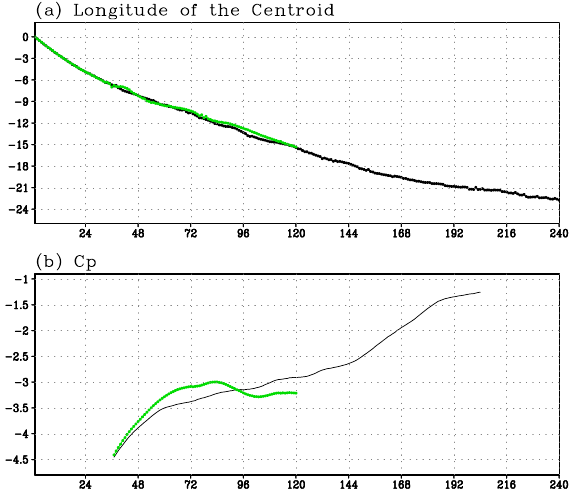
Fig. 6. (a) The longitude of the mass centroid and (b) the propaga- tion speed (Cp) of the gyre-pouch based on its vorticity centroid as described in the text. The black curves represent the coarse- resolution simulation, and the green curves represent the warm-rain experiment. The abscissa is time (h). The ordinate is longitude in (a) and propagation speed (ms − 1 ) in